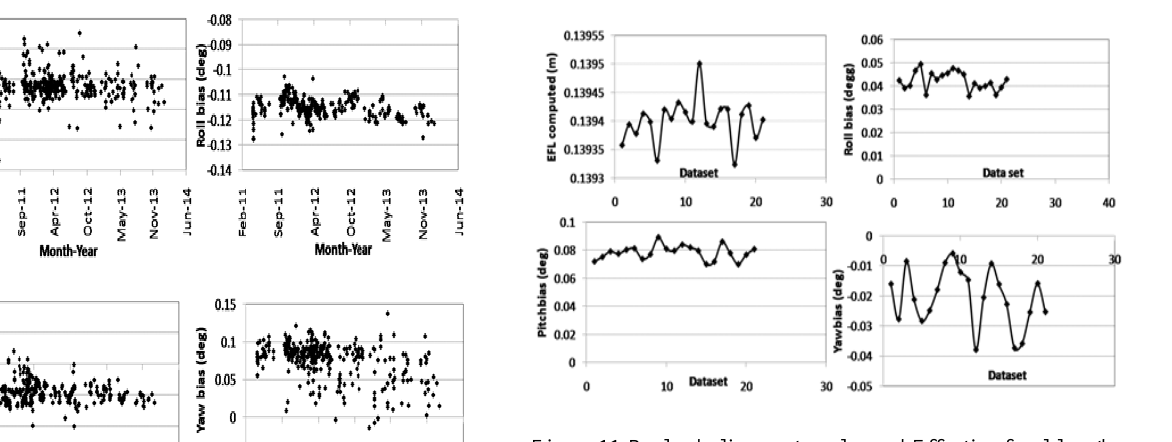
Figure 11 Payload alignment angles and Effective focal